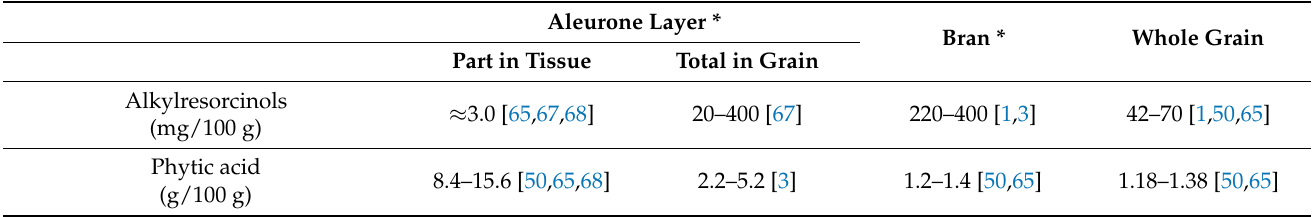
Table 6. Repartition of bioactive components in the wheat aleurone layer, bran and whole